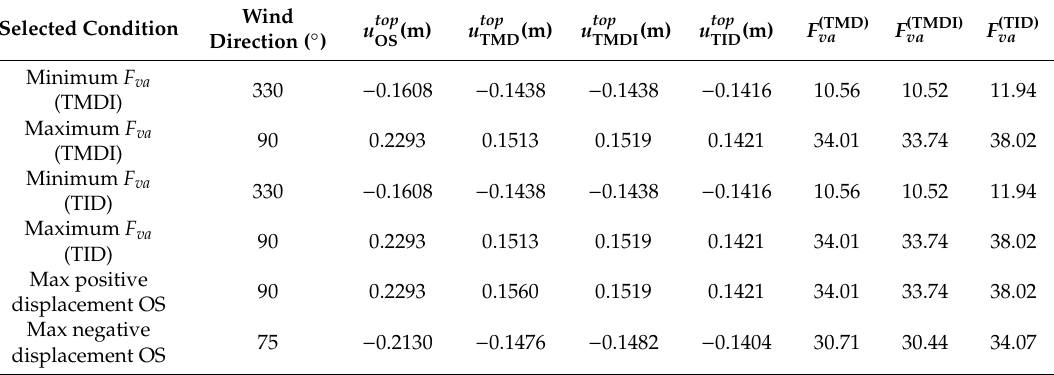
Vibration-mitigation e ff ects in terms of top-floor displacement response for some loading